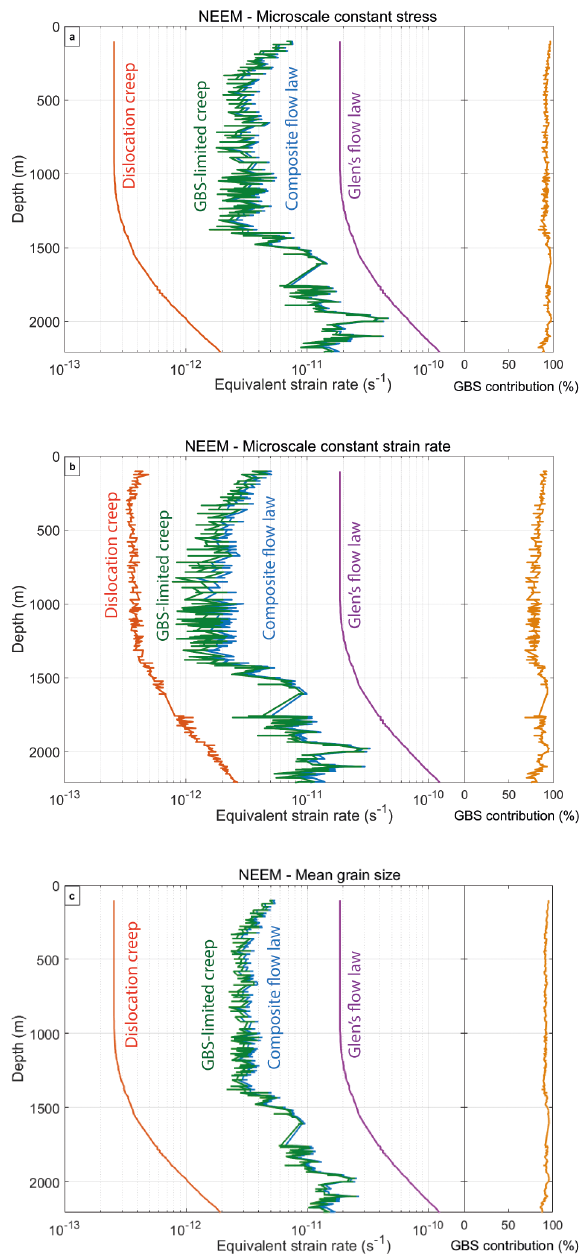
Figure 9. (a) Results for the Holocene and Glacial ice for Glen’s flow law (purple, the same in a , b , c ) and the composite flow law (blue) using the flow law parameters in Table 2, which consist of dislocation creep (red) and GBS-limited creep (green), using (a) the microscale constant stress model with the grain size distribution, (b) the microscale constant strain rate model with the grain size dis- tribution and (c) the composite flow law with the average grain size data. The contribution of GBS-limited creep to bulk strain rate for all three model end-members is shown. A constant effective stress of 0.07MPa was used for all